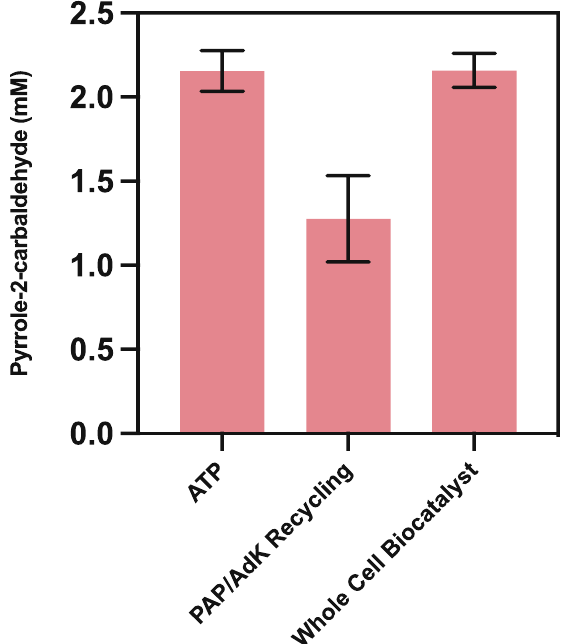
Figure 5. Comparative aldehyde yield obtained by the reduction of supplemented ATP from 20 mM to 0.25 mM in the presence of 0.25 mg/mL each of AjPAP and AjAdK enzymes and 4 mg/mL sodium hexametaphosphate using purified PA0254 and CARse enzymes. Compared against the yield obtained with whole-cell CARse biocatalyst at OD600 = 20, supplemented with glucose to 50 mM in the presence of purified PA0254. No carboxylation of pyrrole was observed in controls lacking biocatalysts for any